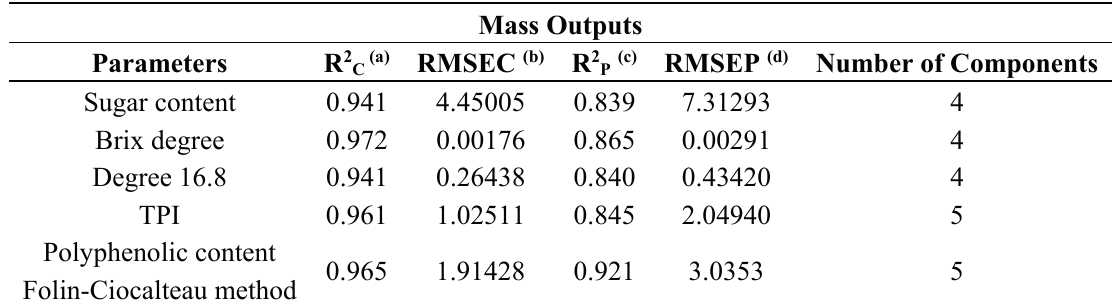
Table 3. Statistical parameters obtained for the N-PLS regression model established between the chemical parameters and the mass responses of the sensors towards